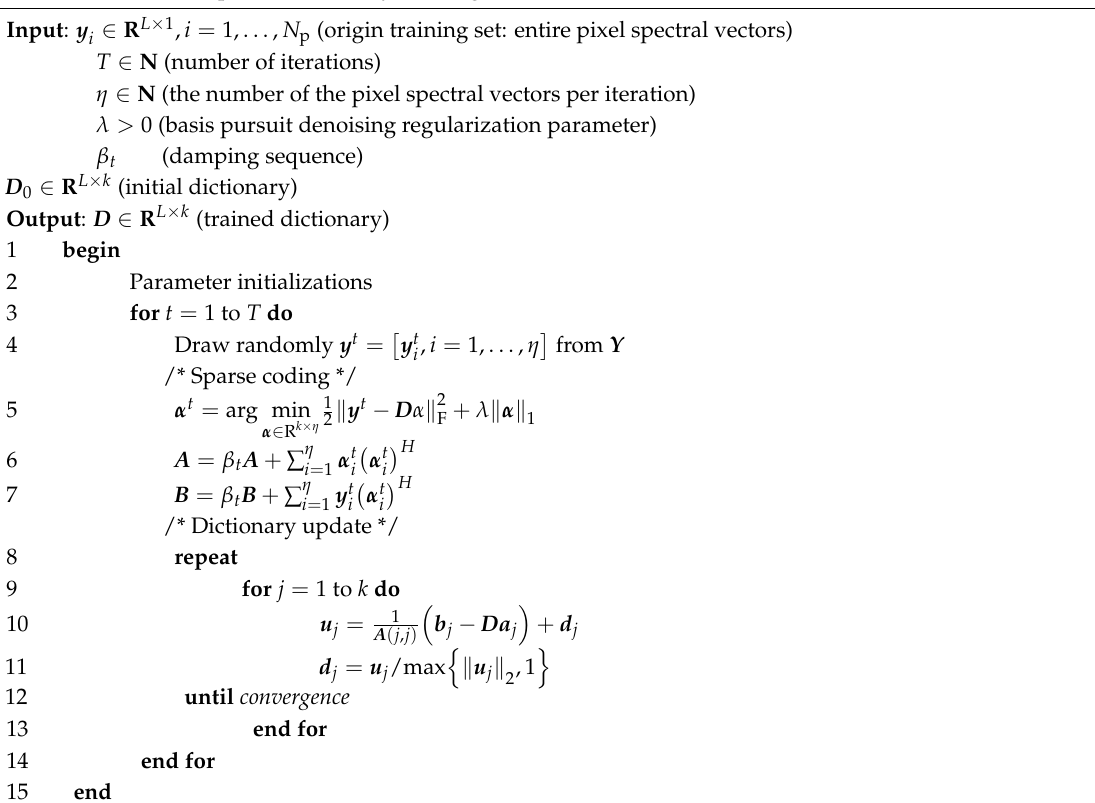
Algorithm 1 Online spectral dictionary learning (OSDL)